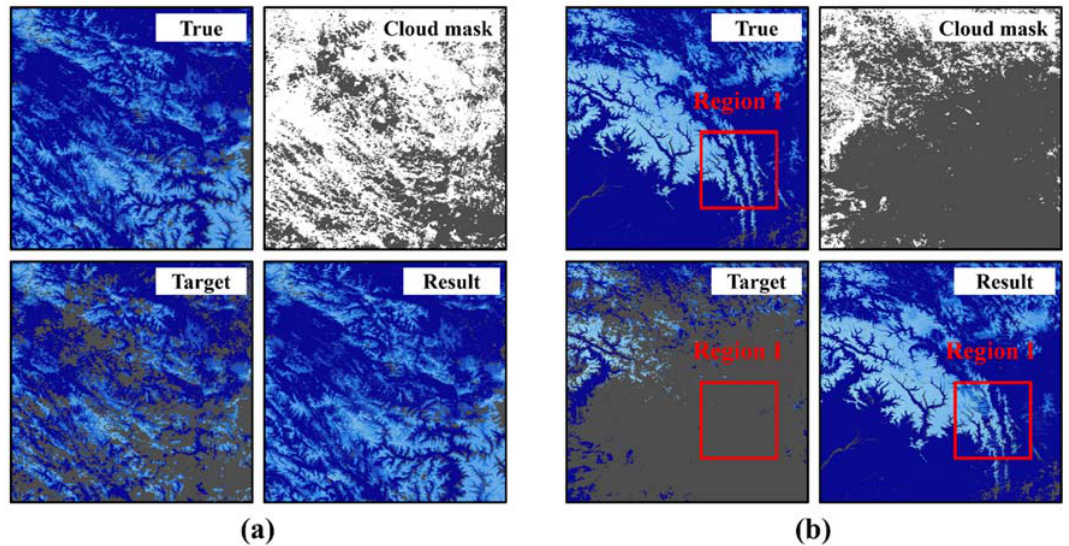
Figure 15. SPSA results of ( a ) a small scattered patch of clouds and ( b ) extensive cloud cover from a MODIS image located in southeastern TP. The upper-left panel shows a subset of a true MODIS NDSI image from 12 / 092 ((a) CGF = 3.4%, (b) CGF = 4.6%). The upper-right panel represents the corresponding subset of a cloud mask from 08 / 120 ((a) CGF = 35.59%, (b) CGF = 77.64%) including clouds (gray) and clear sky (white). The lower-left panel illustrates the hypothetical target image that was generated from the true image and the cloud mask image. The lower-right panel is the corresponding reconstructed NDSI image using the proposed SPSA algorithm.